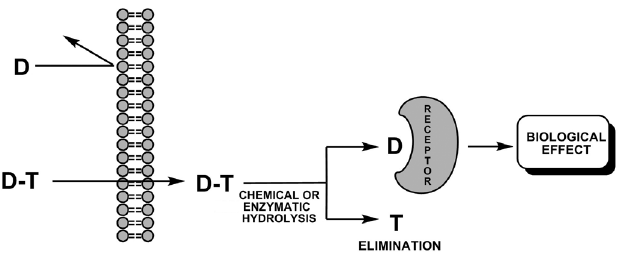
FIGURE 1 - Diagram of the latentiation process. (D: drug, T: transporter group, D-T: prodrug) Adapted from Friis and Bundgaard(1996).